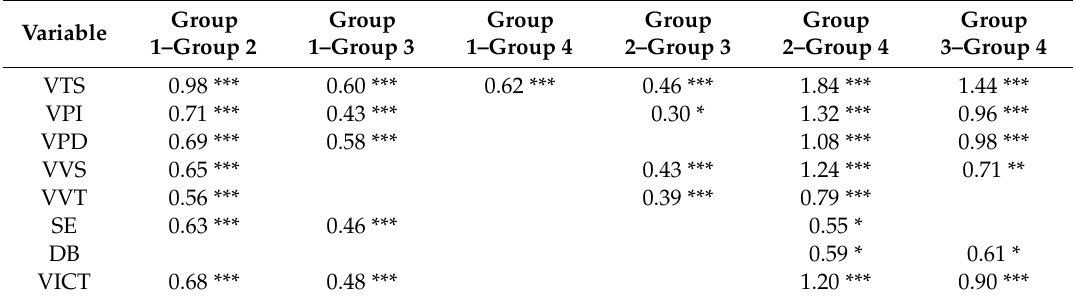
Table 4. Cohen´s d indexes for post- hoc contrast